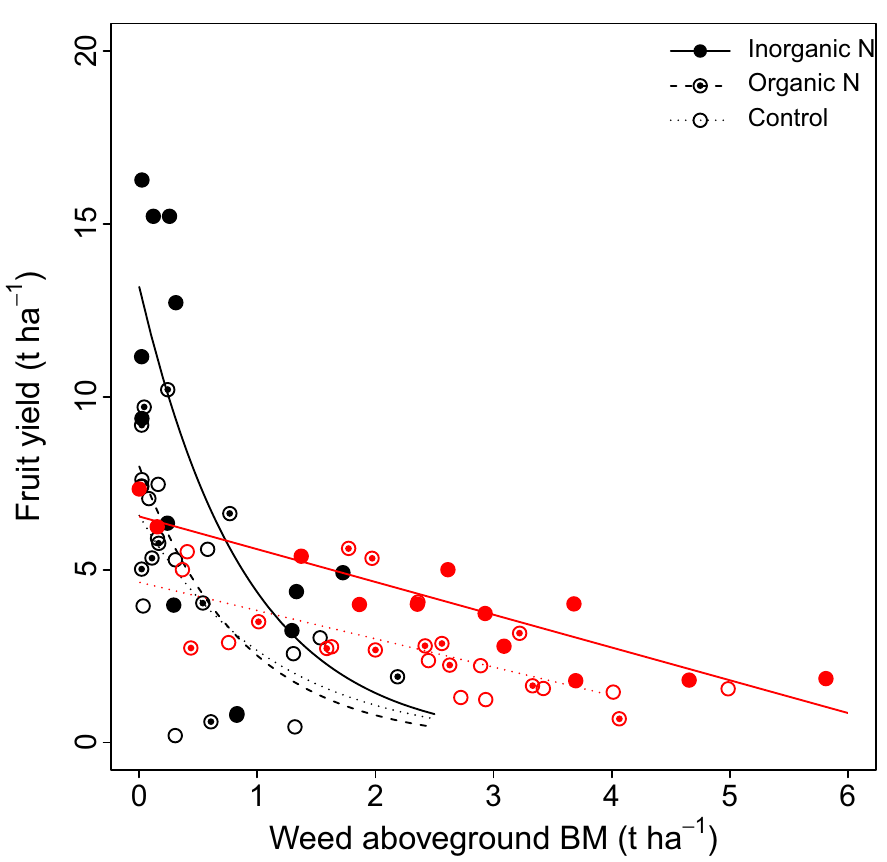
Fig 3. Relationship between lowbush blueberry fruit yield (t ha -1 ) and the aboveground biomass of weeds (t ha -1 ). Values are shown for C . peregrina (red symbols) and D . spicata (black symbols) under the three fertilization treatments (inorganic N, organic N, and control). Curves show significant relationships ( P < 0.05). C . peregrina plots–Inorganic N: y = 6.53–0.94x ( R 2 = 0.82); Control: y = 4.63–0.82x ( R 2 = 0.63). D . spicata plots–Inorganic N: y = 13.18e 1.11x ( R 2